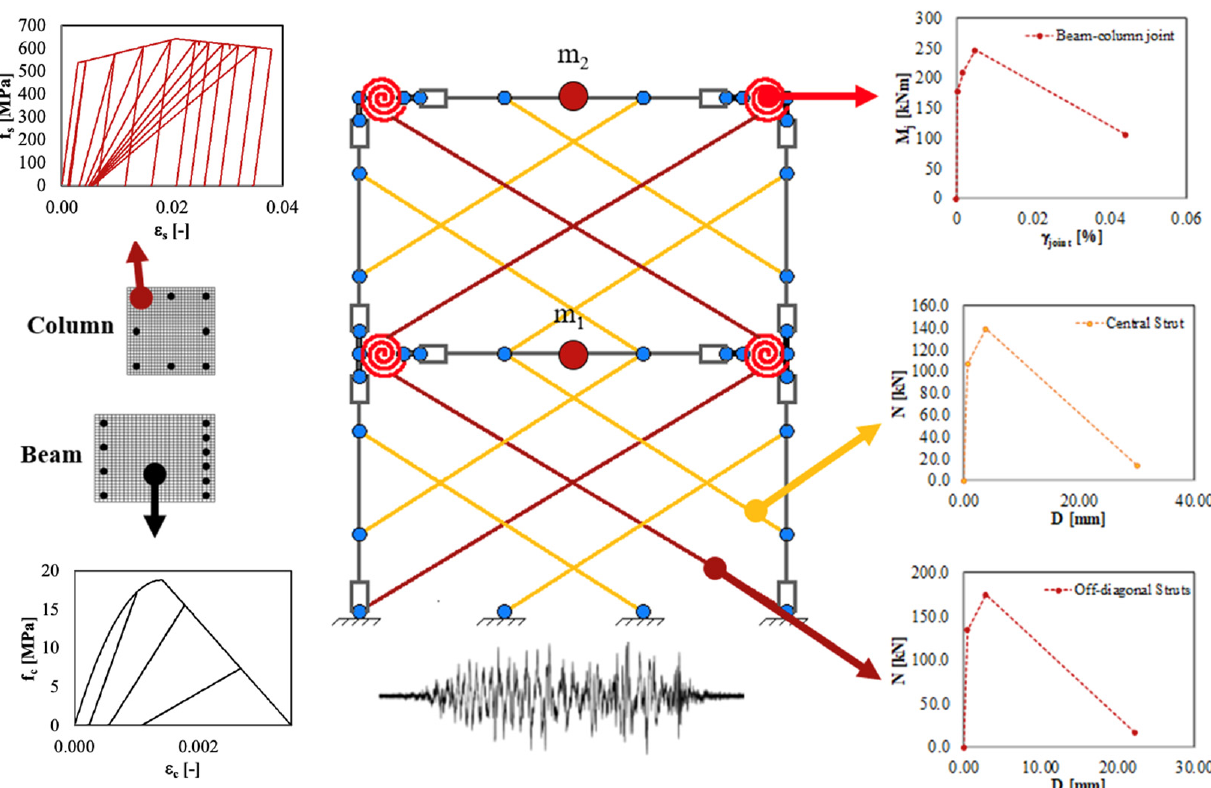
Figure 6. Schematic view of the FE model with four-sided infills walls. The beam-column joints are modelled as rotational springs with a Pinching4 material, adopting the model proposed by De Risi et al. [25]. According to the model, the backbone of the beam-column capacity curve is represented as a curve with four linear branches defined by the critical points reported in Table 7 in terms of shear stress ( τ j ) and rotation ( γ ). Table 7. Beam-column joint backbone critical